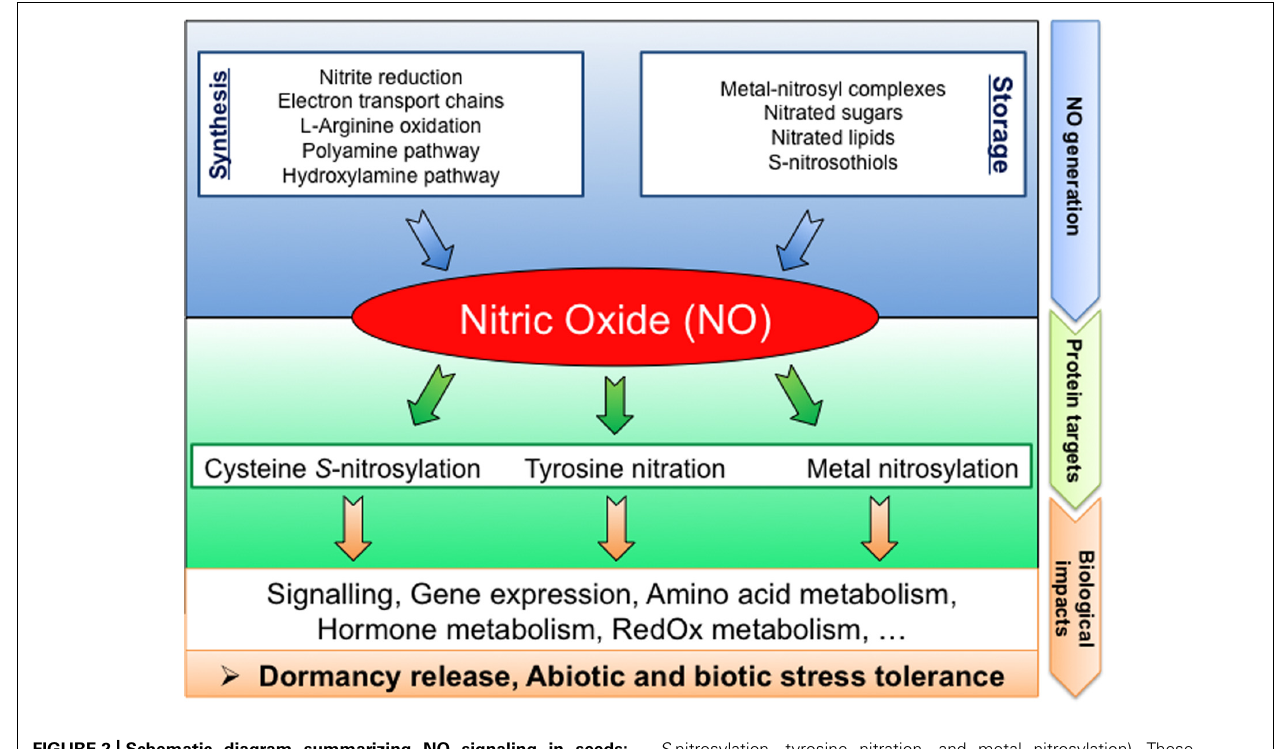
FIGURE 2 | Schematic diagram summarizing NO signaling in seeds: from generation to targets. NO can be produced by various biosynthesis pathways or released from NO-storage compounds. Proteins are preferentially targeted by NO resulting in PTMs (cysteine